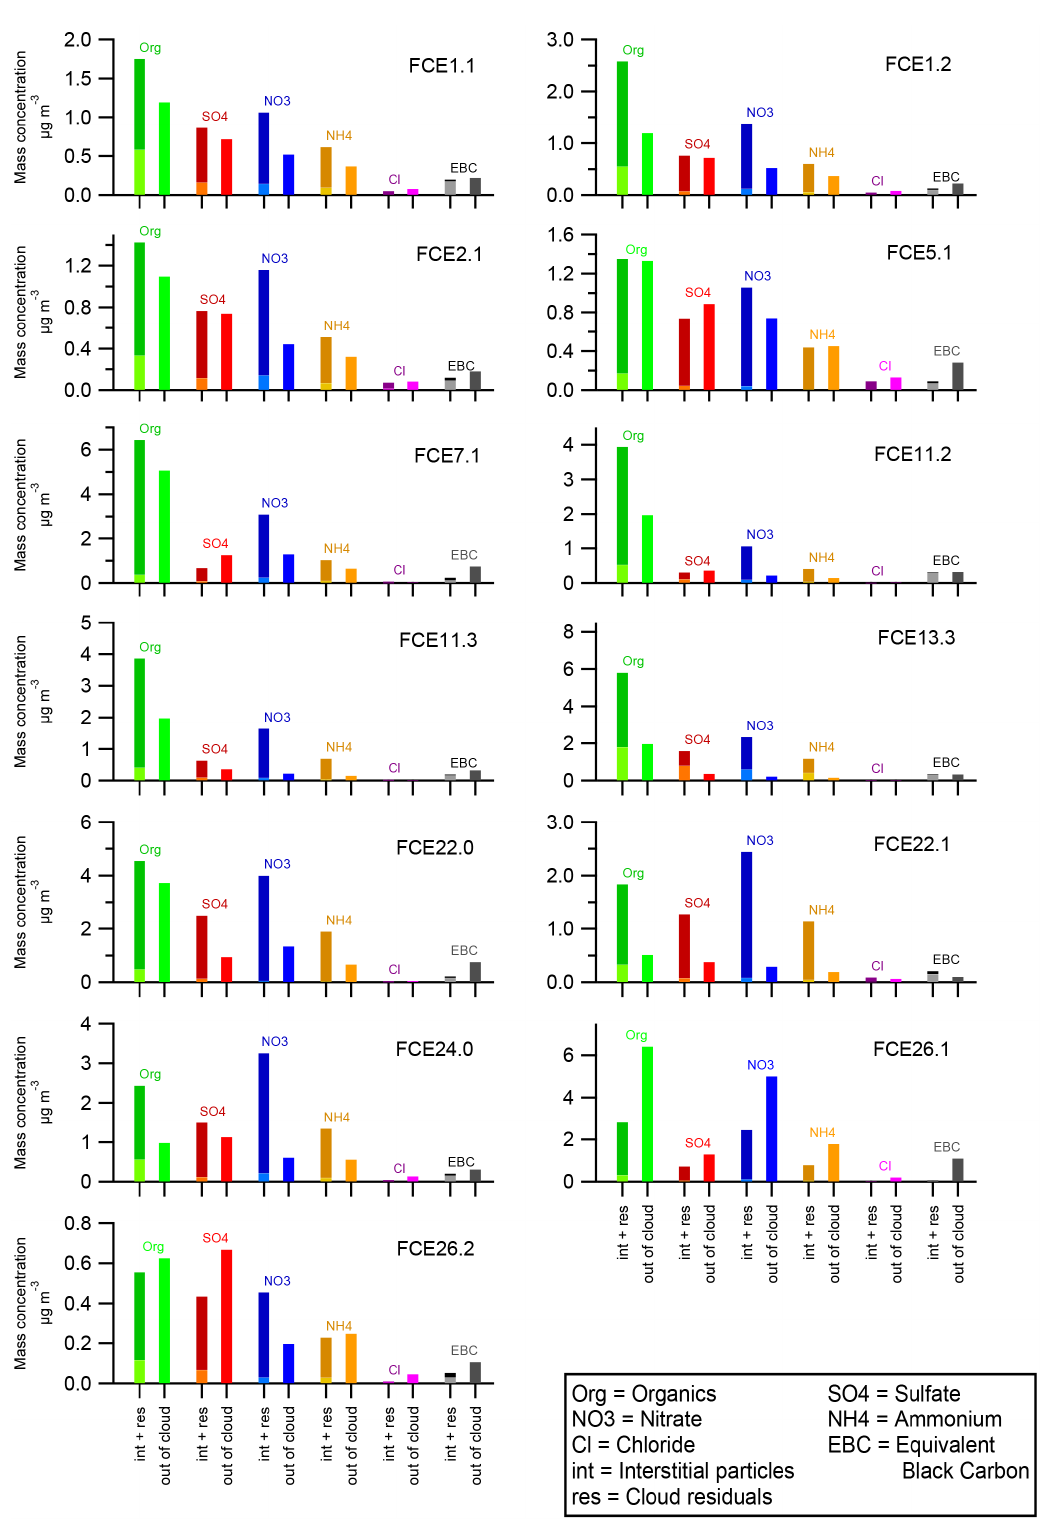
Figure 3. Composition of cloud residual and interstitial particle mass concentration during the full cloud events (FCEs) and particle mass concentration during corresponding non-cloud times. Interstitial and out-of-cloud aerosol particles were measured using the HR-ToF-AMS, cloud residuals were analyzed using the C-ToF-AMS. The first bar shows the sum of the residual concentration (“res”) and the interstitial concentration (“int”); residual concentration (darker color) is stacked on top of the interstitial concentration (lighter